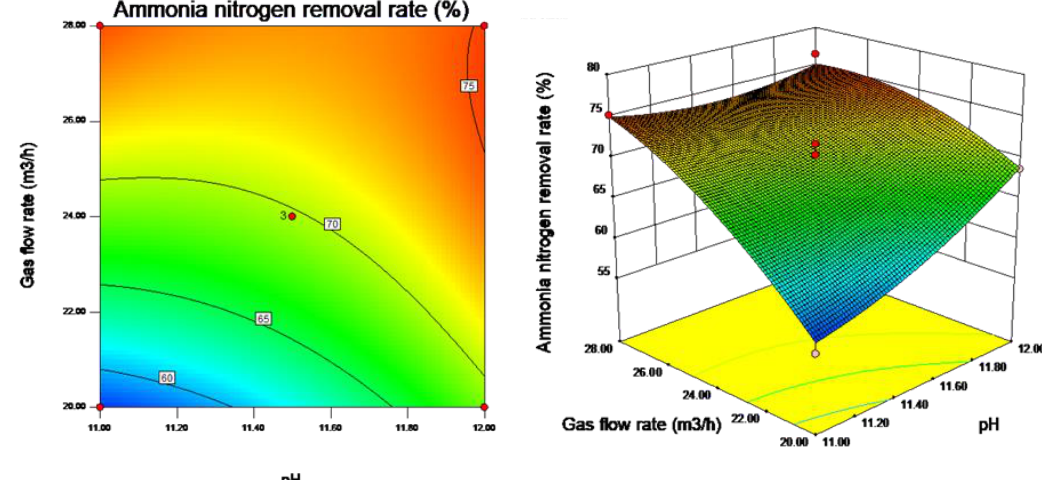
Figure 7. Contour plot and response surface plot of the effect of pH value and gas flow rate on ammonia nitrogen removal rate.